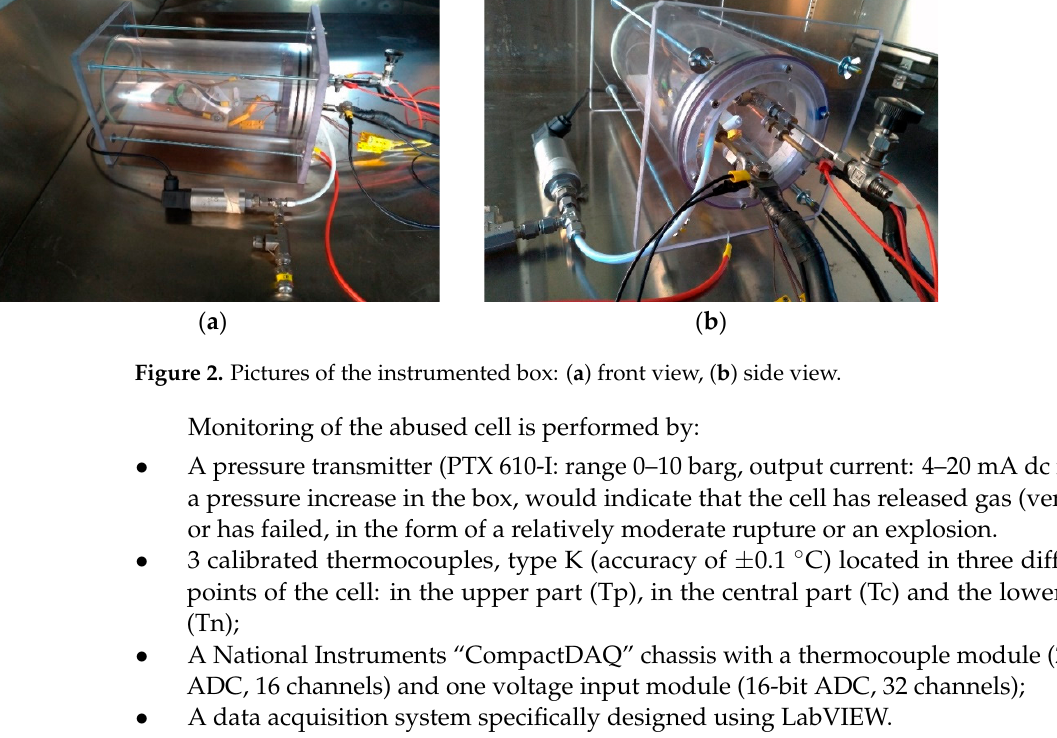
Figure 1. Climatic chamber for abuse test.